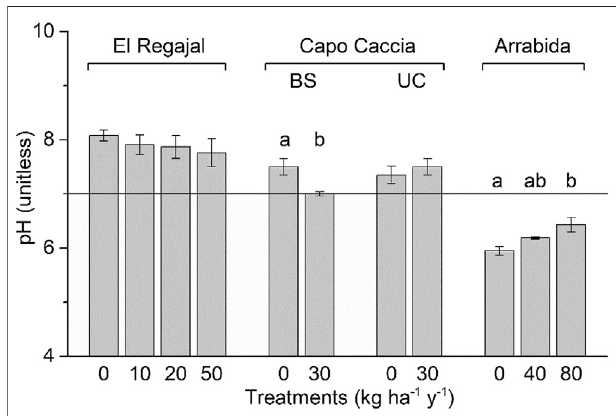
FIGURE 2 | Effect of nitrogen (N) addition on soil pH (means ± SE) in the top 8 cm of the soil pro fi le for each N treatment in El Regajal (Spain, n (cid:2) 6), Capo Caccia BS (Italy, n (cid:2) 4), Capo Caccia UC (Italy, n (cid:2) 4) and Arrábida (Portugal, n (cid:2) 3). Capo Caccia BS and UC indicate bare soil and under canopymicrosites,respectively.Lettersindicatesigni fi cantdifferencesamong N treatments within each site ( p < 0.05, one-way ANOVA, post hoc LSD test). The solid line indicates neutral pH.